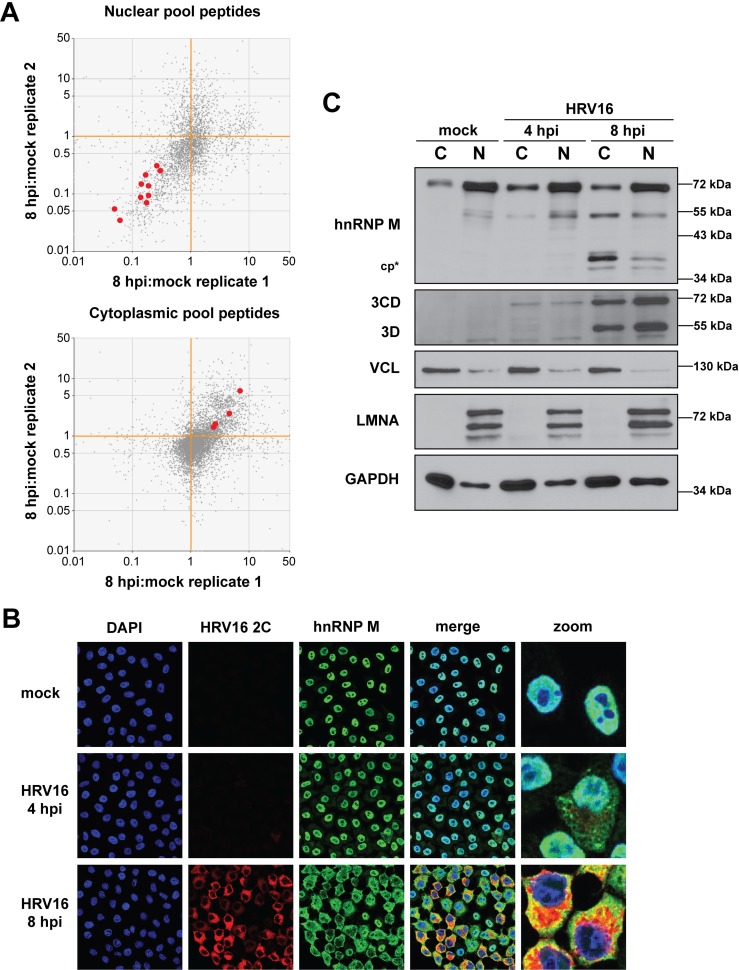
Heterogeneous nuclear ribonucleoprotein M (hnRNP M) redistributes to the cytoplasm of HRV16-infected HeLa cells.(A) Tryptic peptides in Fig 2 that correspond to hnRNP M are highlighted red, clearly reflecting the nucleocytoplasmic redistribution of this protein 8 hours post infection (hpi) by HRV16. (B) HeLa cells were mock- or HRV16-infected (MOI 10) then fixed 4 or 8 hpi. Cells were permeabilized then probed, via indirect immunofluorescence, for HRV16 2C (red), a marker of HRV16 RNA replication sites, and cellular protein hnRNP M (green). DNA was counterstained with DAPI to indicate location of nuclei (blue). Cells were then imaged using confocal microscopy. (C) HeLa cells were mock- or HRV16-infected (MOI 10), fractionated at the indicated times, and fractions were analyzed by Western blot. Cleaved hnRNP M was observed 8 hpi in both the cytoplasmic and nuclear fractions (cp*). HRV16 3D and its precursor 3CD were used as markers of infection. VCL and LMNA were used as markers of the cytoplasmic (C) and nuclear fractions (N), respectively, and GAPDH was used as a general loading control.